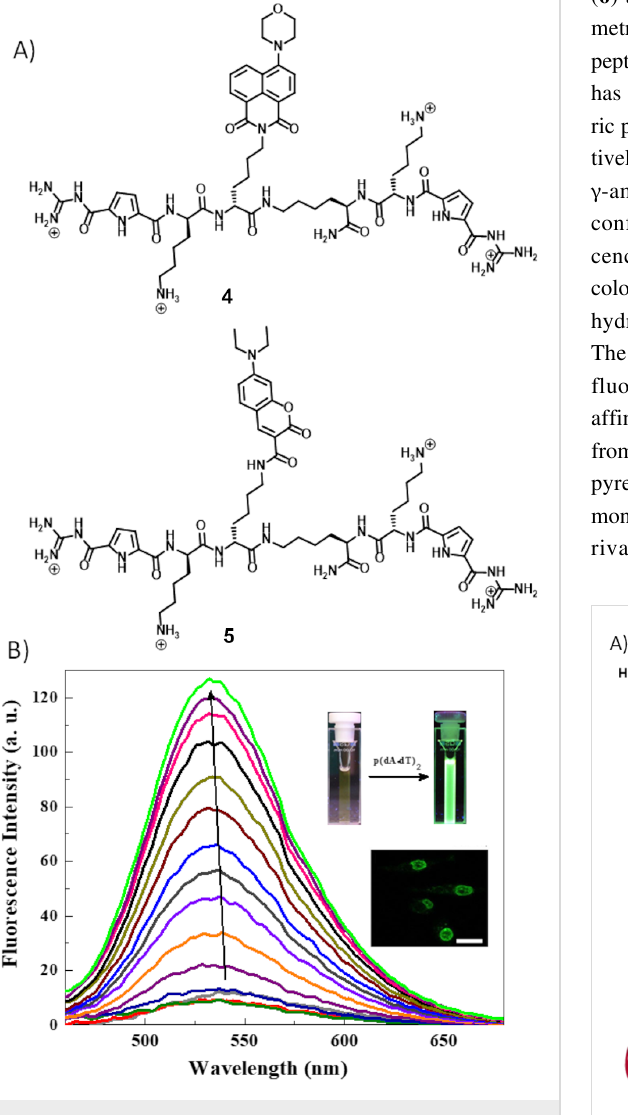
Figure 5: A) Molecular structure of 4 and 5 ; B) fluorescence spectra for the titration of a 0.5 μ M solution of 4 with increasing concentration of p(d A ·d T ) 2 ( λ ex = 410 nm). Inset: fluorescence switched-on after ad- dition of dsDNA inside the cuvette, nuclei of A549 cells stained with 4 .